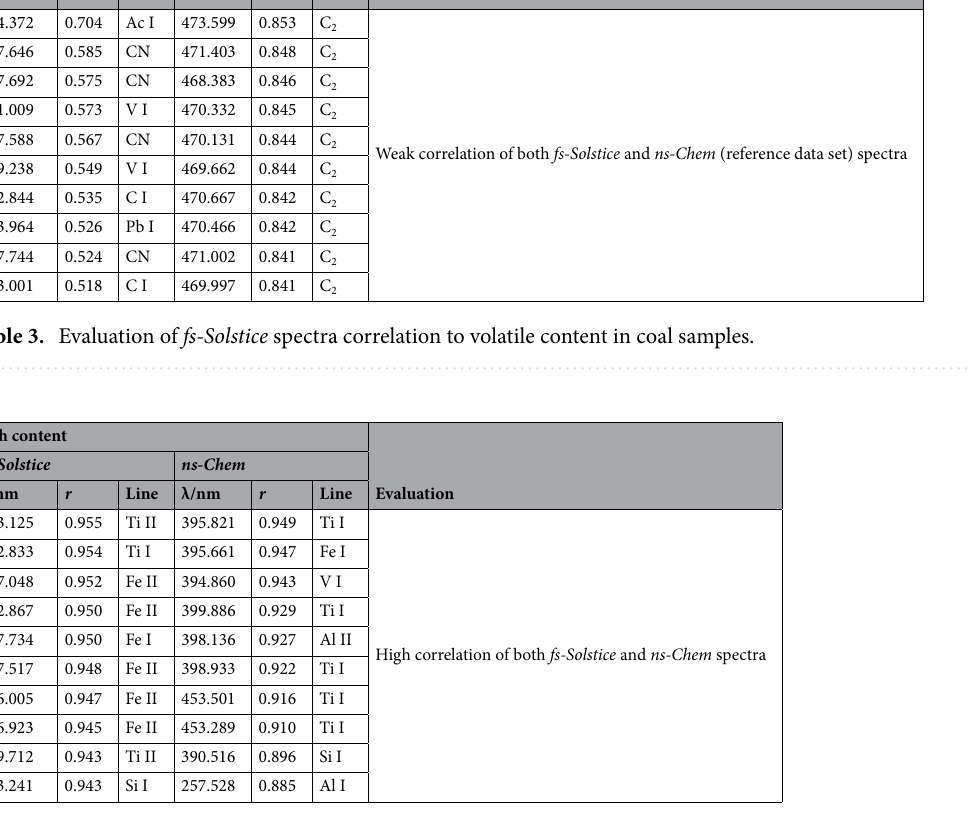
Table 4. Evaluation of fs-Solstice spectra correlation to ash content in coal samples.